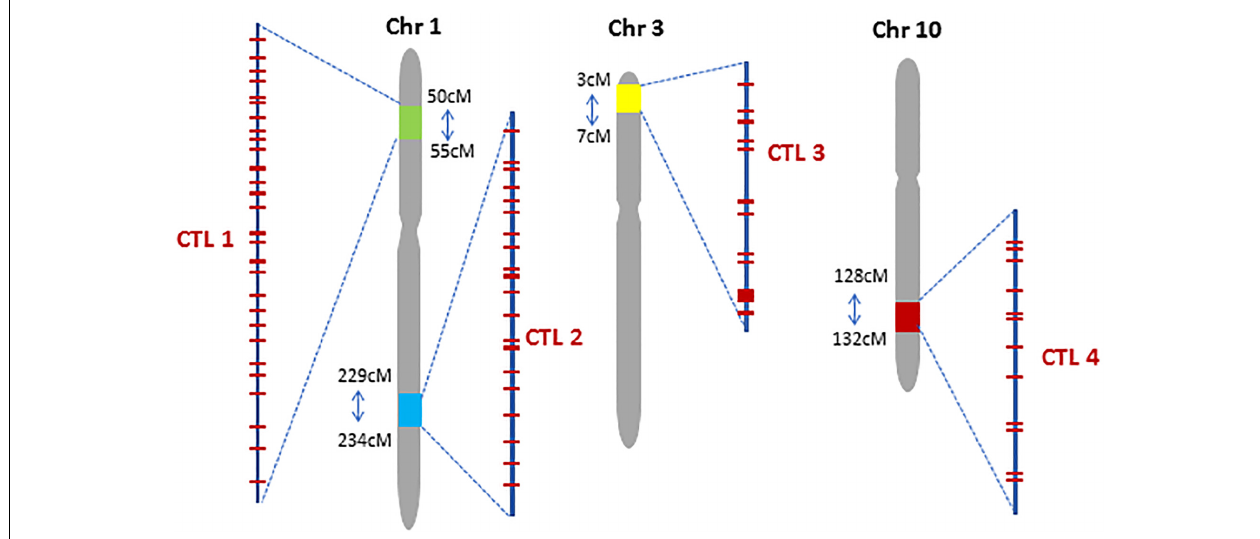
FIGURE 1 | Chromosomal location of four Complex Trait Loci (CTL) in the maize genome. Red bars within each CTL represent preselected CRISPR targeting